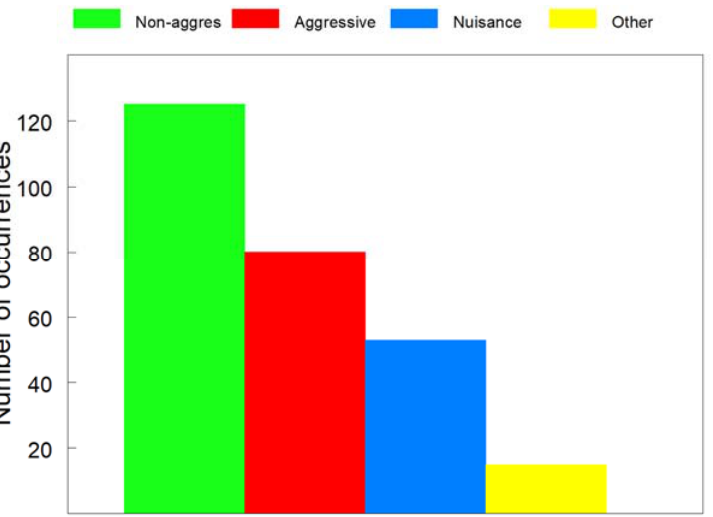
Figure 3. A breakdown of 200 popular media news stories about urban wildlife. Some stories en- compassed more than one perspective and so appear more than once. See Supplementary Material for